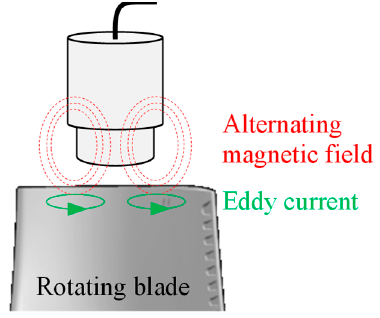
Figure 12 . Principle of an EC sensor . Figure 12. Principle of an EC